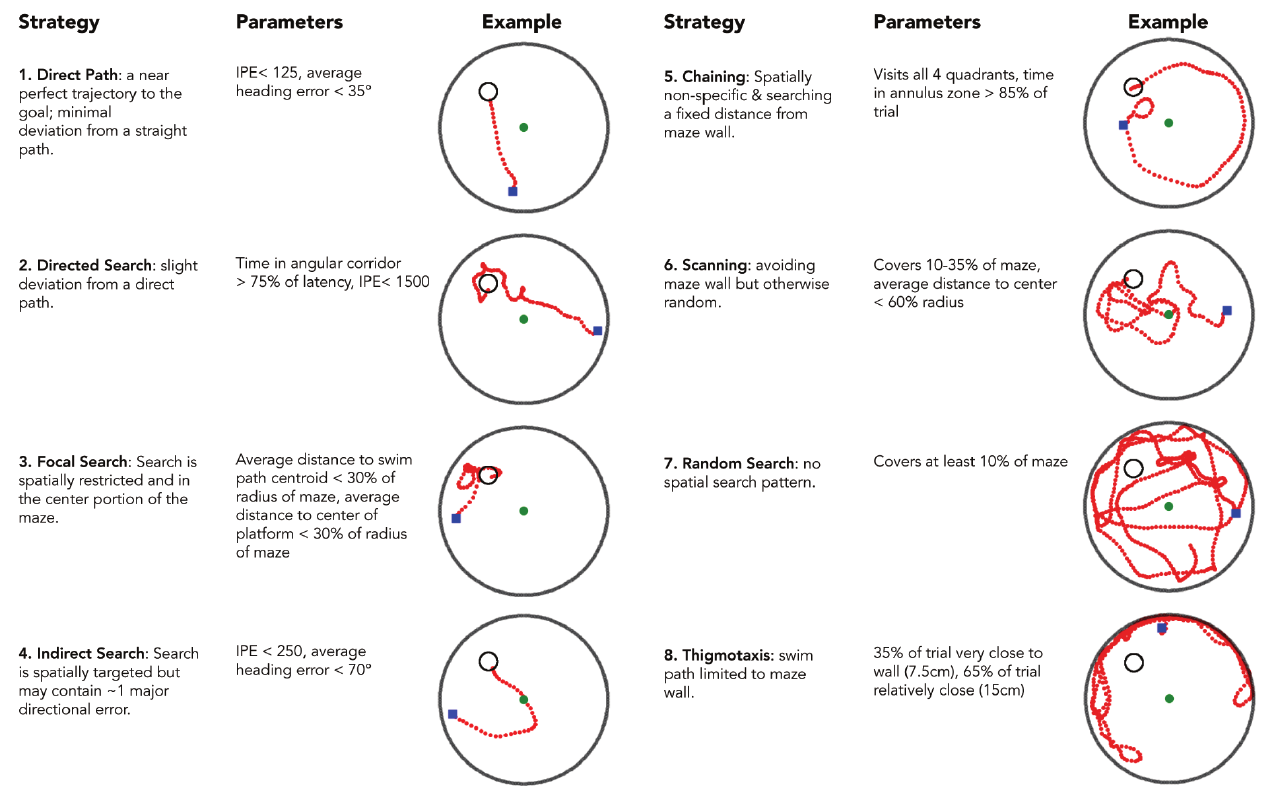
Figure 2. Search strategies and associated parameters. Pathfinder categorizes each trial according to 1 of 9 possible strategies. Categorization proceeds sequentially in the order shown (unless some strategies are excluded from the analysis). Semi-focal search (not- shown), a more relaxed focal-search, is classified 5 th after indirect search. For example, for a trial to be classified as Random Search, the path must cover a minimum proportion of the maze and not fit any of the criteria for strategies 1–7. In the examples shown, the blue square indicates the start point and the green circle indicates the middle of the pool. Parameter settings are those used in the present study and should be adjusted depending on changes to testing procedures and maze